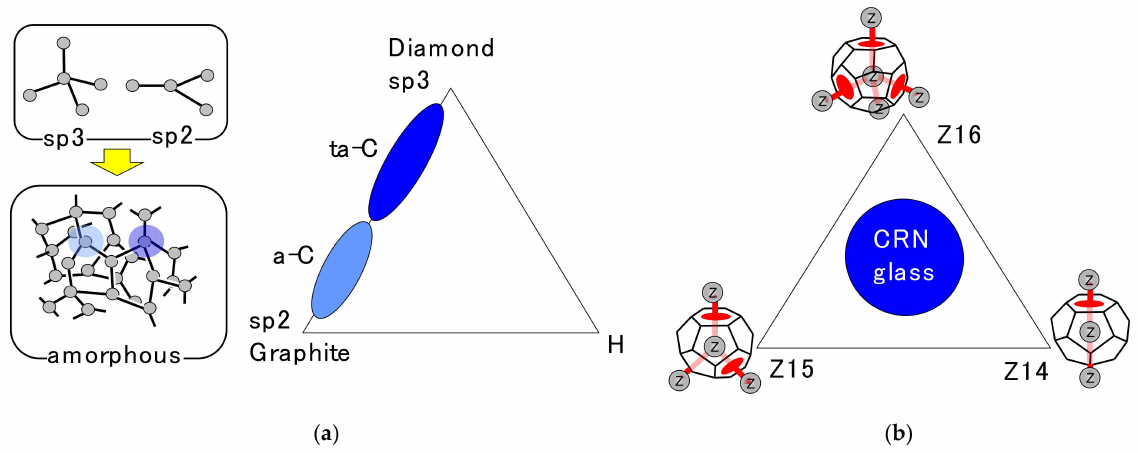
Figure 18. ( a ) Short-range order ( left , top ) and medium-range order ( left , bottom ) in amorphous carbon and a schematic diagram for amorphous carbon ( right ). ( b ) Schematic diagram for CRN glass formed by Z-clusters connected by 6- ring